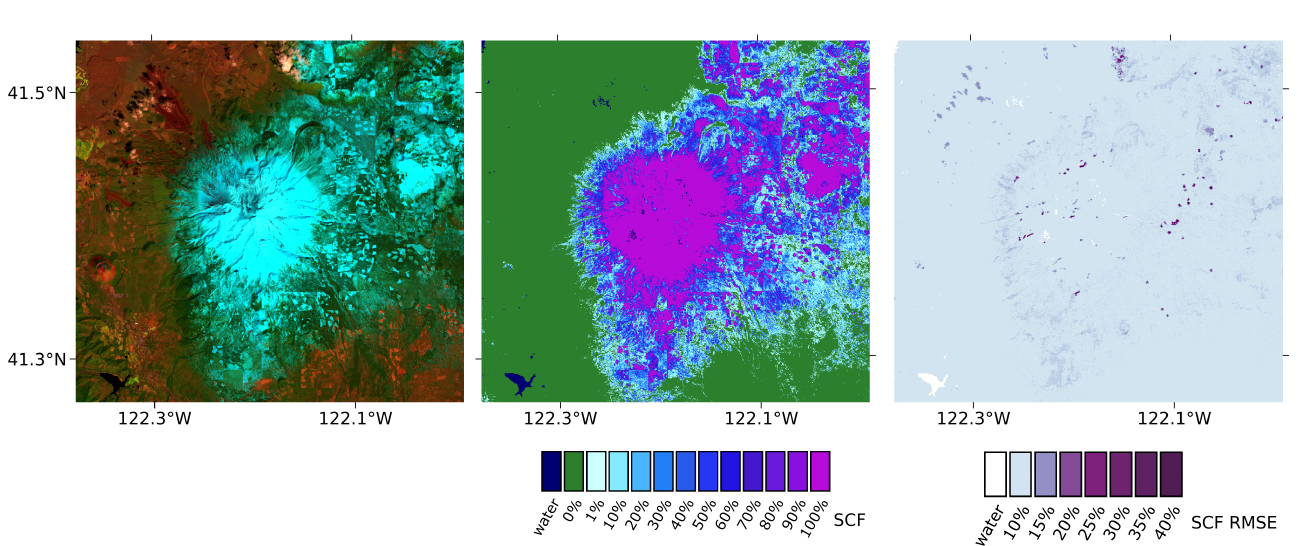
Figure 7. ( Left ): Landsat 8 OLI false colour composite (band 6, 5 and 3) over Mount Shasta in North-California in the U.S. taken on 2 April 2017 (path 045, row 031). ( Center ): LAMSU SCF derived from Landsat 8 OLI data at 30 m resolution. ( Right ): LAMSU SCF RMSE at 30 m resolution. Water mask source: EC JRC/Google.